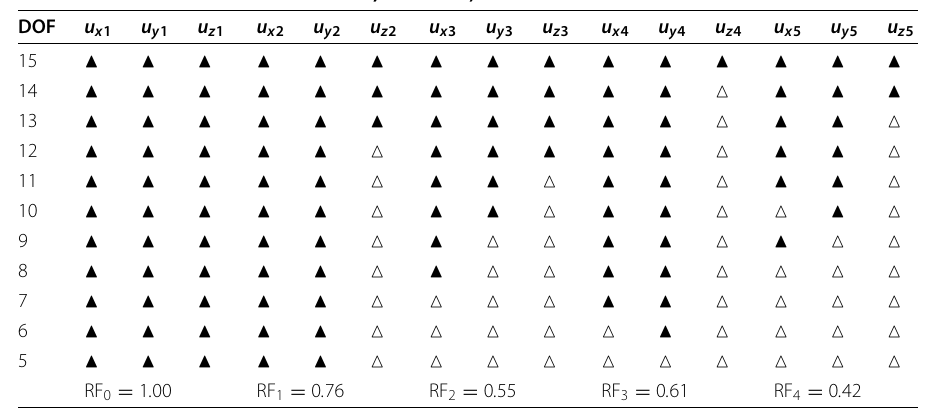
Table 10 BTD models for 0/90/0/90, R/a = 50 , a/h = 10